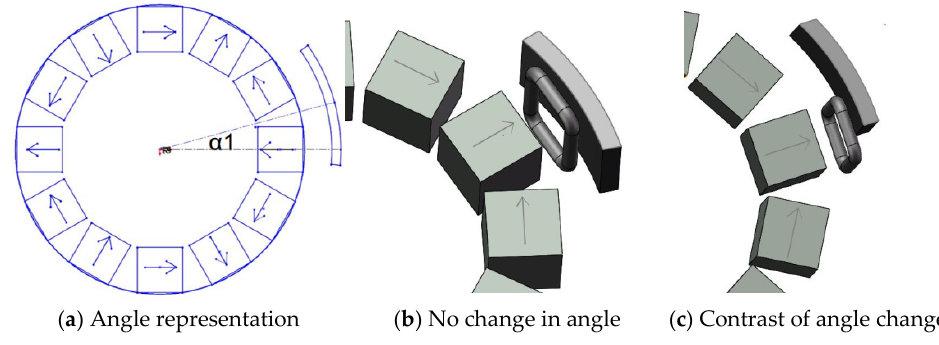
Figure 3. The angle between Halbach array and iron sheet.